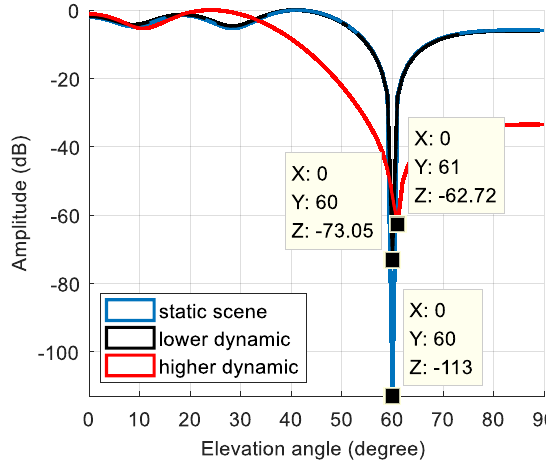
Figure 16 . The null depth corresponding to the static scene, the lower dynamic scene and the higher dynamic scene.